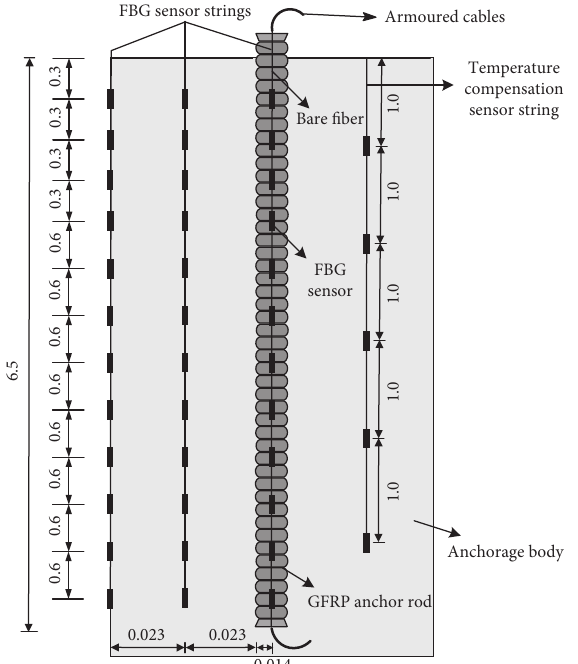
Figure 5: Arrangement of sensor strings (unit: m).